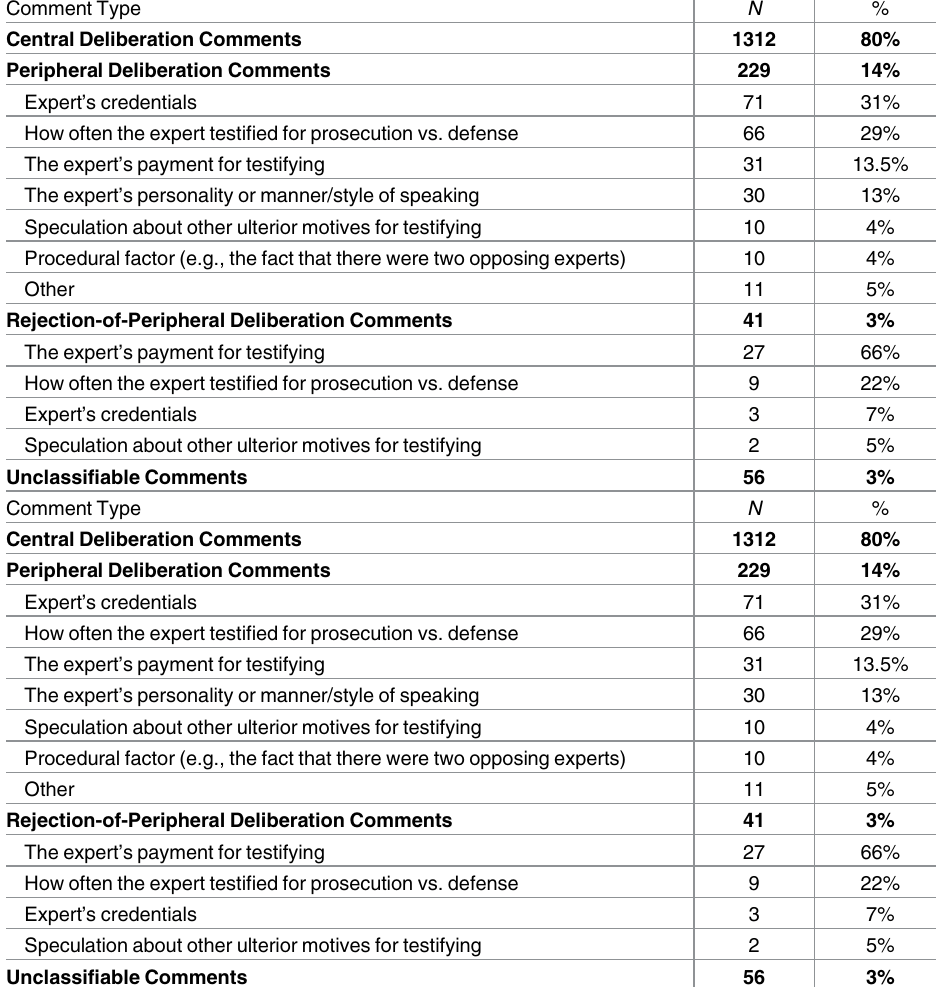
Table 2. Breakdown of comments made about experts during deliberation (n =